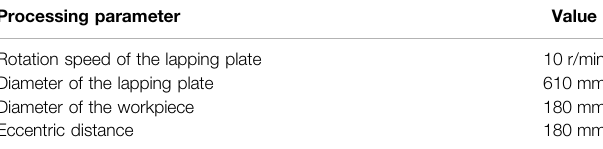
TABLE 1 | Processing parameters in simulation.